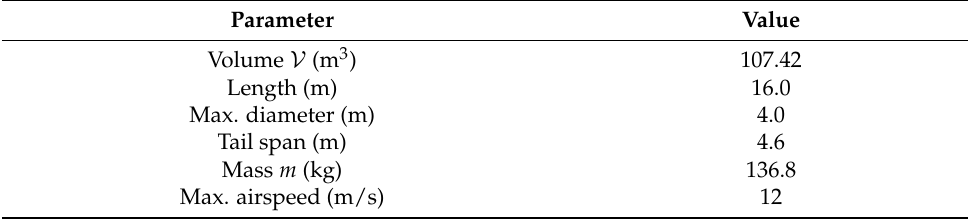
Table 2. Basic specifications of Lotte airship